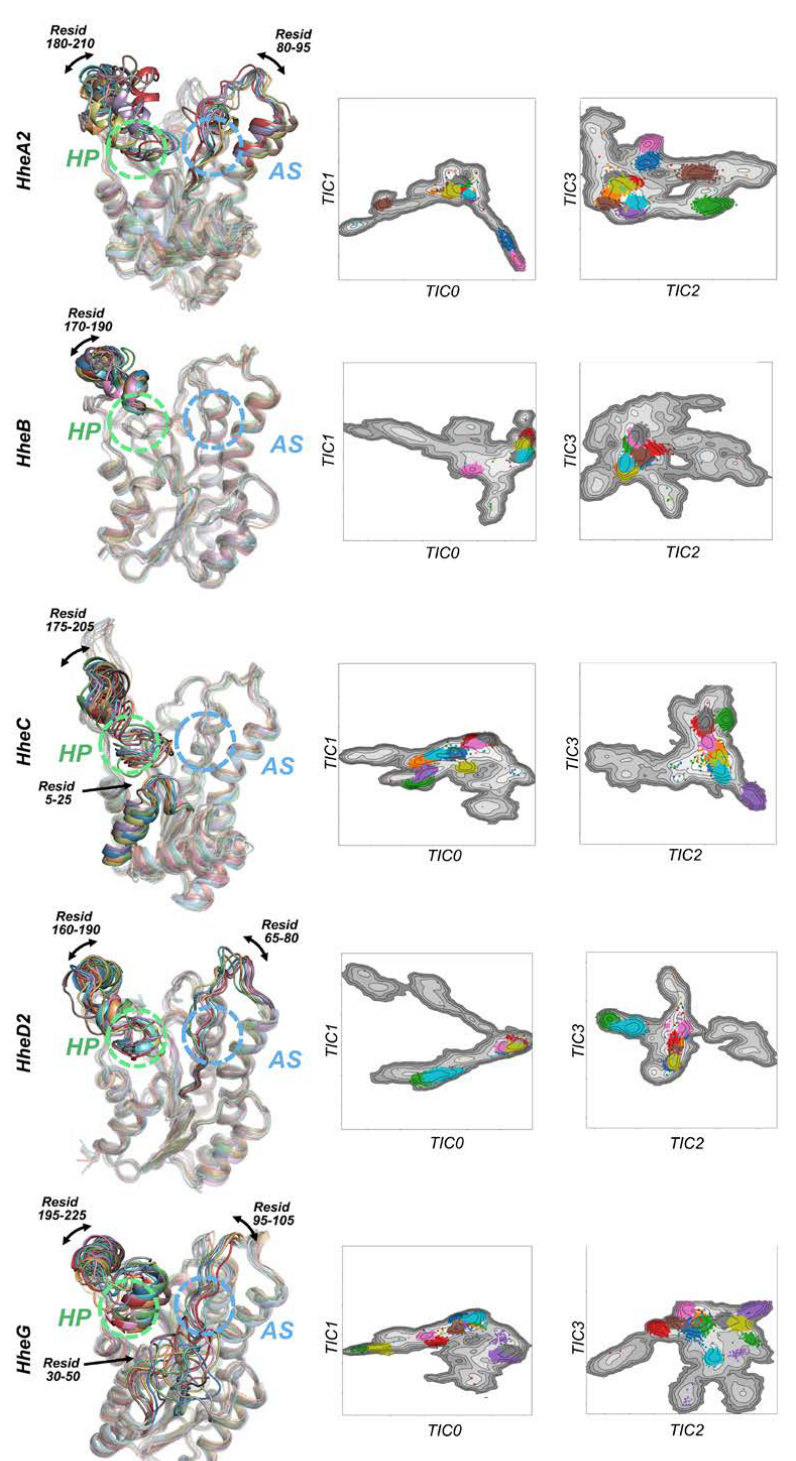
Figure 3. Representation of the 10 most populated MD conformations as described by the t-SNE technique for the di ff erent HHDH subclasses analyzed: HheA2, HheB, HheC, HheD2, and HheG. The 10 di ff erent conformations (each one colored di ff erently) are projected on the tICA conformational landscapes. The most flexible parts of the enzymes are marked and numbered accordingly. The location of the active site (AS) and halide binding pocket (HP) are marked with a green and blue discontinuous circle,